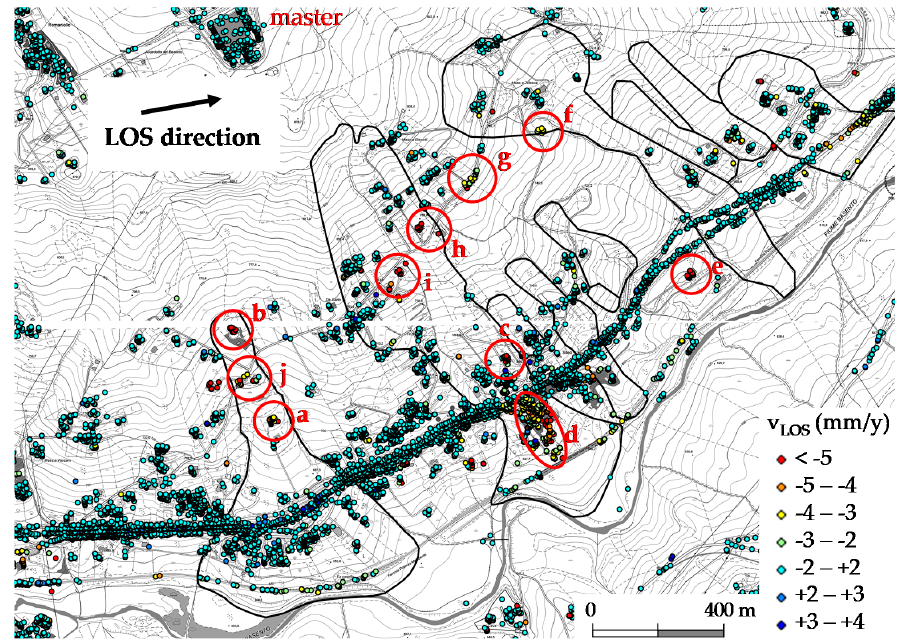
Figure 11. Average rates of the line of sight (LOS) displacement of monitored scatterers in the period May 2011–March 2014 evaluated from COSMO-SkyMed ascending data.